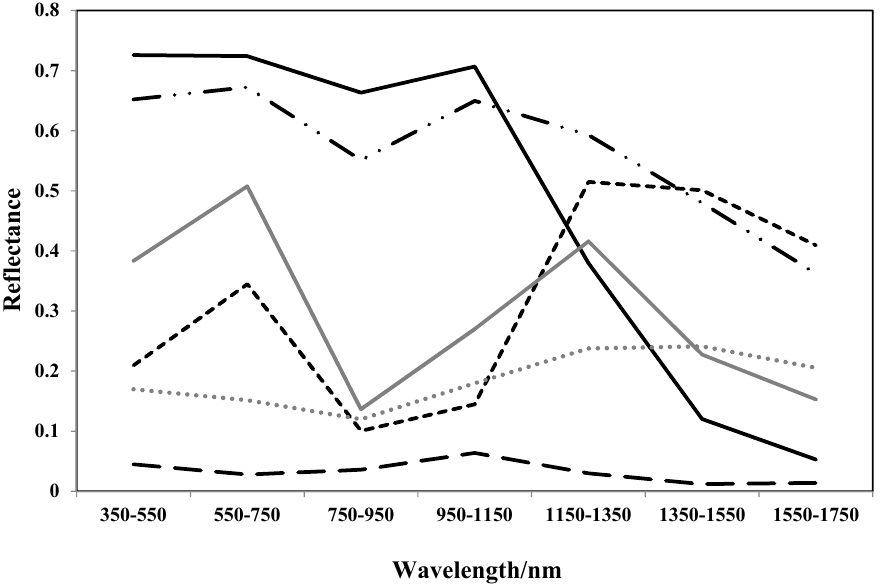
Figure 5. Spectral curves of five surface features and cloud.